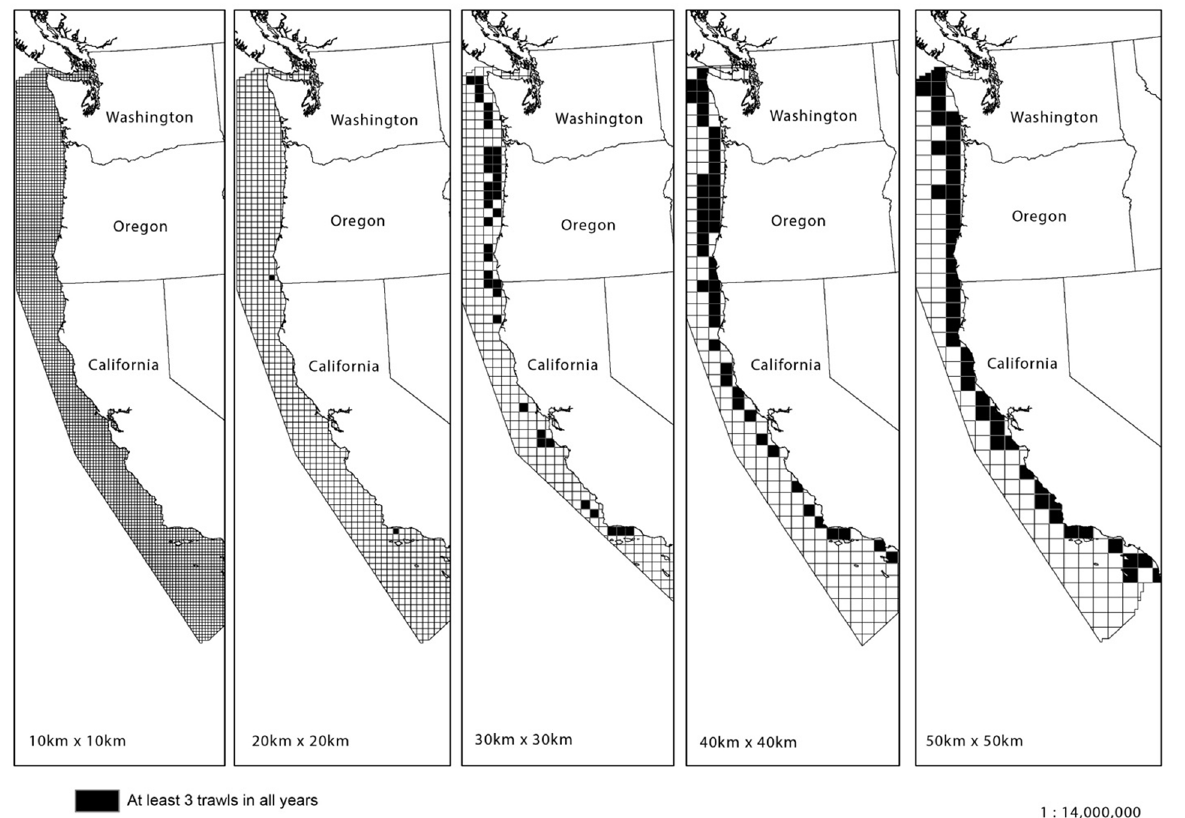
Fig 2. Expanding window approach used to identify cells that contained at least three trawls for each year (2003 – 2010). 1600 km 2 (40 x 40 km) cells offered both the highest number of cells that qualified, as well as a high degree of spatial connectivity between the